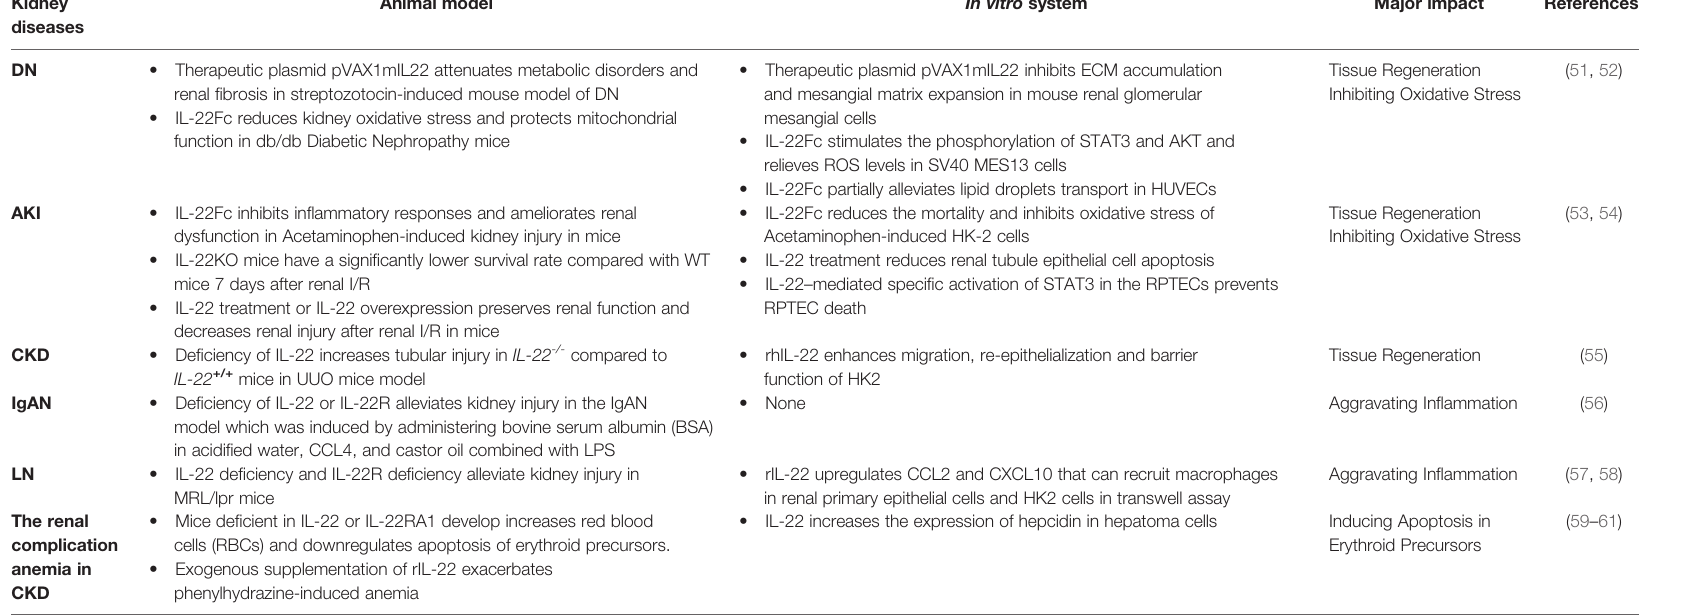
TABLE 1 | Diverse Roles of IL-22 across Different Kidney